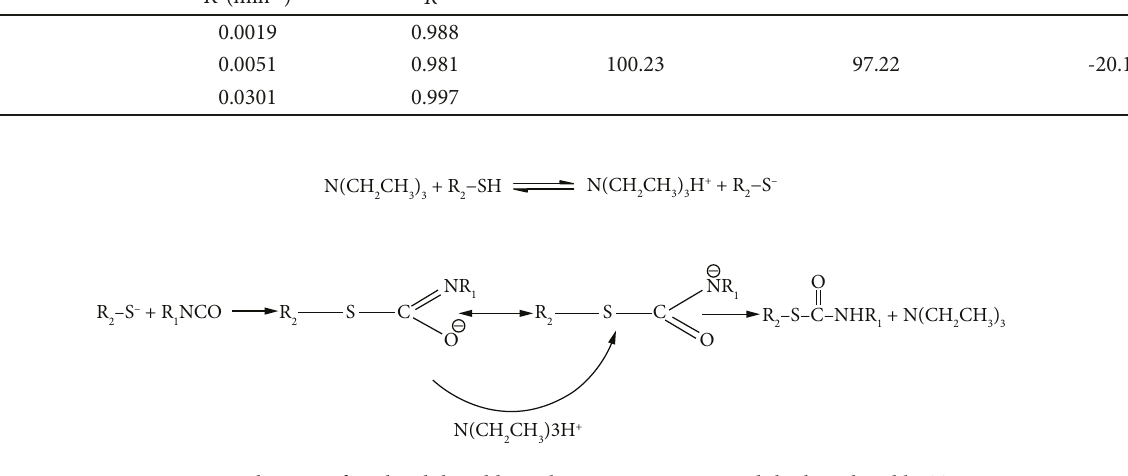
Table 2: First-order kinetic parameters and thermodynamic parameters of PSU curing process with 150 ppm TEA. 1st-order Temperature (K)